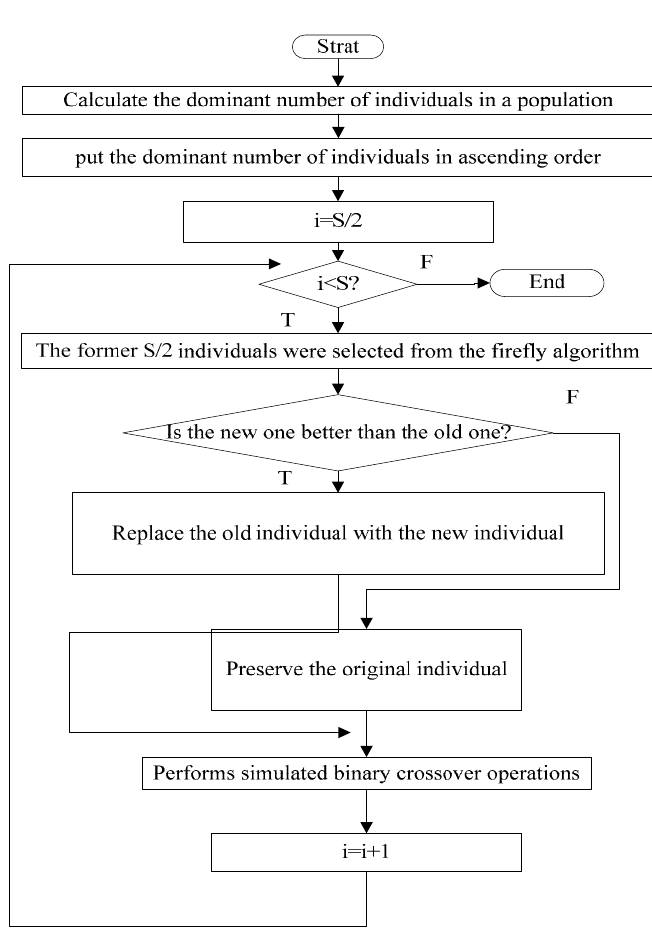
Figure 2. flow chart of the improved for replication operation.